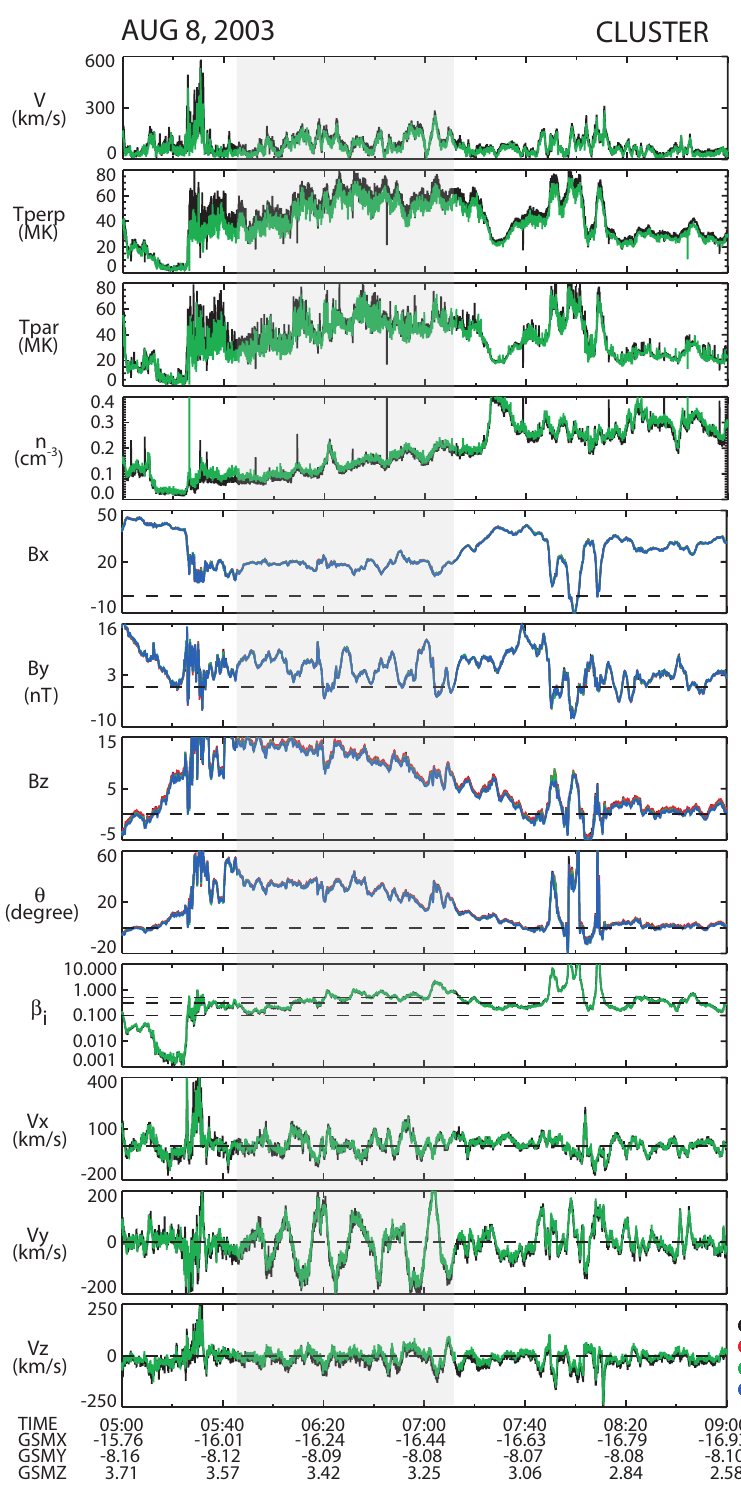
Fig. 3. Cluster data during 05:00–0900 UT, including both ion moment data and magnetic field data. The highlighted region is the interval during which quasi-periodic oscillations were seen. Figure 3 serves as an observational context for the